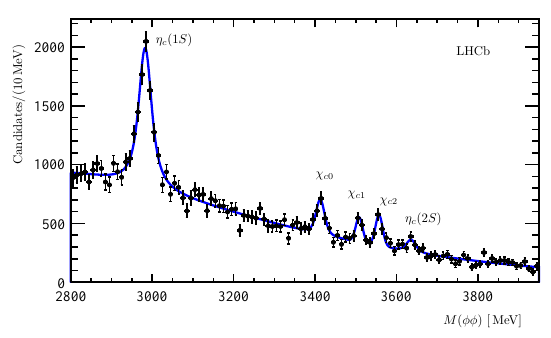
Figure 1. Distribution of the φφ invariant mass for selected b → φφ X candidates. The fitted function is superim- posed in blue from Ref.